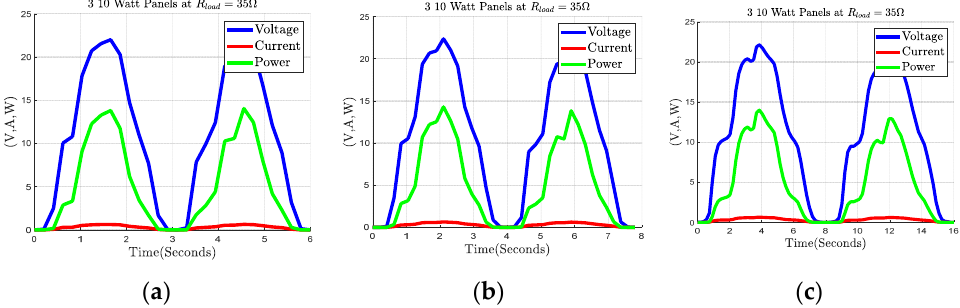
Figure 15. Output voltage, current and power measured while simulated vehicle in motion using the three 10 W EcoWorthy ® solar panels and under different speeds (1.12 m/s ( a ), 2.24 m/s ( b ), and 3 m/s ( c ), from left to right, respectively).